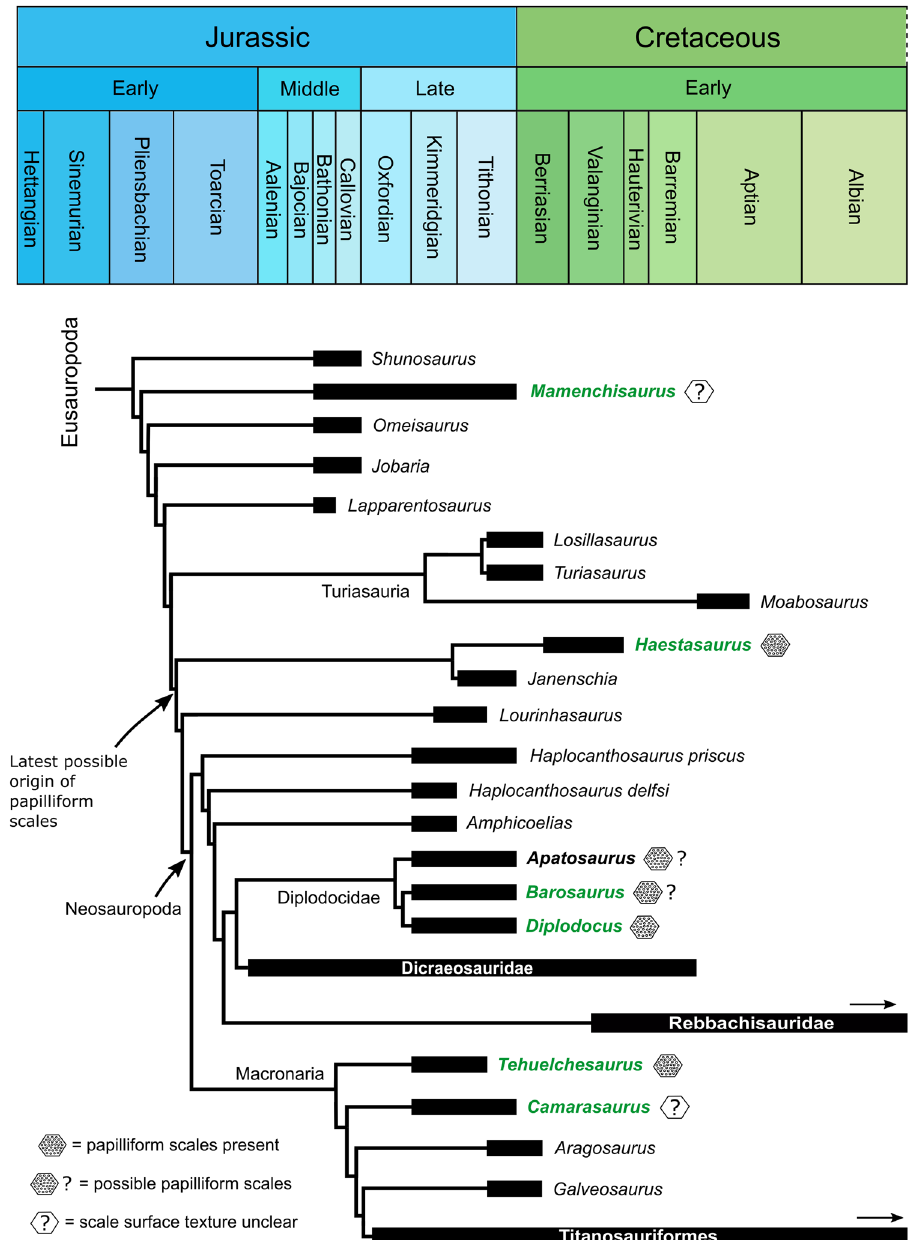
Fig. 5 Time-calibrated phylogeny showing the known distribution of intrascale papillae within Eusauropoda. Tree topology and time-calibrations for non-macronarian nodes are simpli fi ed from Mannion et al. 53 : Fig. 44, with two exceptions: Camarasaurus is presented as a non-titanosauriform macronarian (after Mannion et al. 54 : Fig. 40), and Barosaurus replaces Supersaurus as the sister taxon of Diplodocus (after Xu et al. 55 : Fig. 3). Tree topology and time- calibrations for macronarian nodes are simpli fi ed from Mannion et al. 54 : Fig. 40, with removal of the clade containing Janenschia and Haestasaurus . Green bolded genera indicate taxa for which preserved skin is con fi dently known, while black bold for Apatosaurus re fl ects possible skin occurrence 11 . Known papilliform scale textures are indicated for each bolded taxon. Arrows indicate continuation of a particular lineage into the Late Cretaceous (not shown). Note: the presence of papilliform scale surfaces does not necessarily exclude the presence of smooth scale surfaces in other body